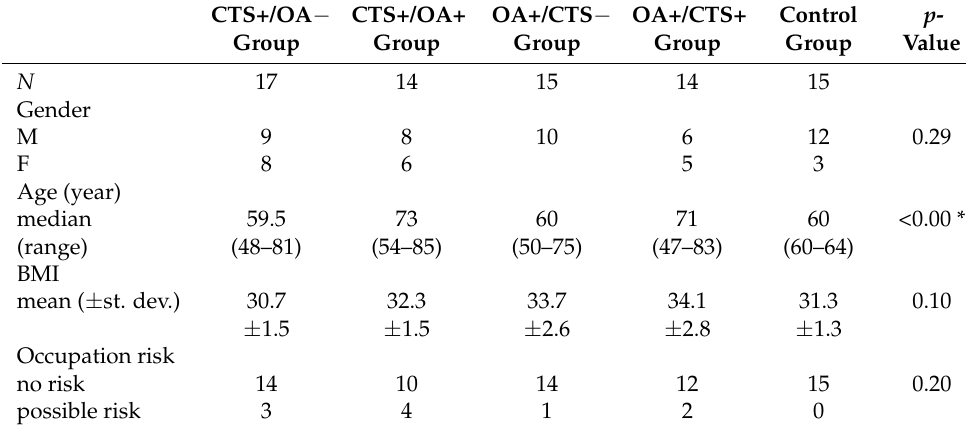
Table 1. Demographic